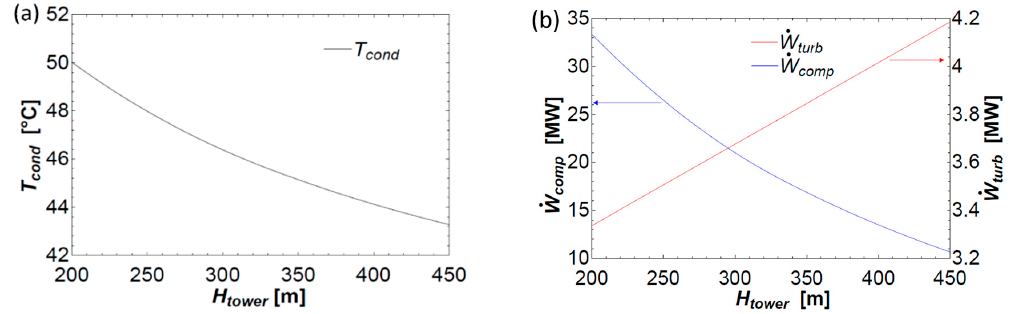
Figure 8. ( a ) Condensing temperature; ( b ) as well as compression work and turbine power output, change with tower height.